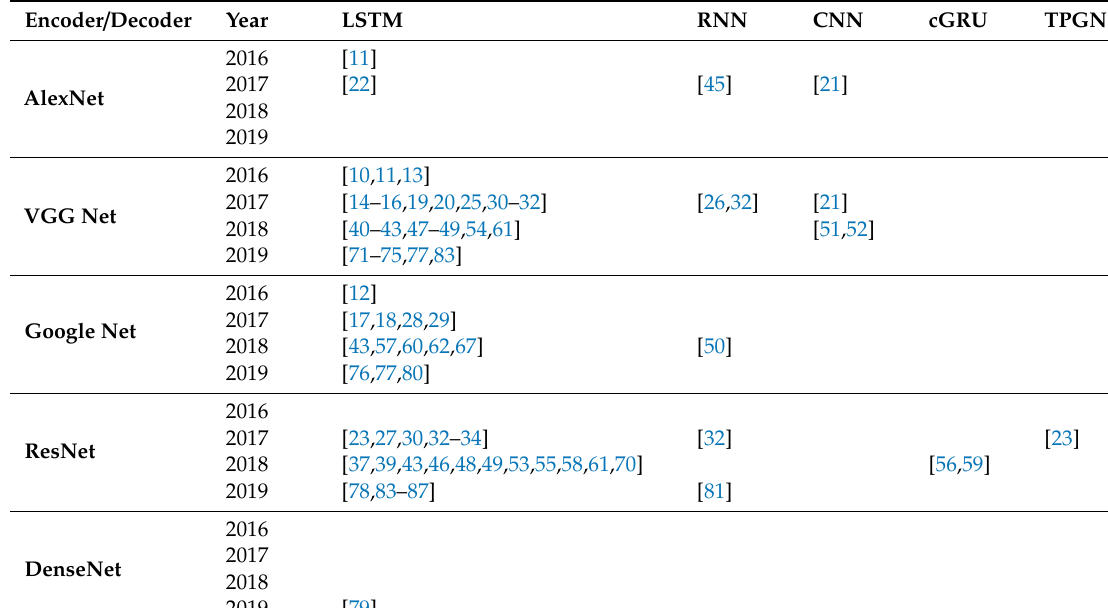
Table 9. Encoder / decoder results by year.